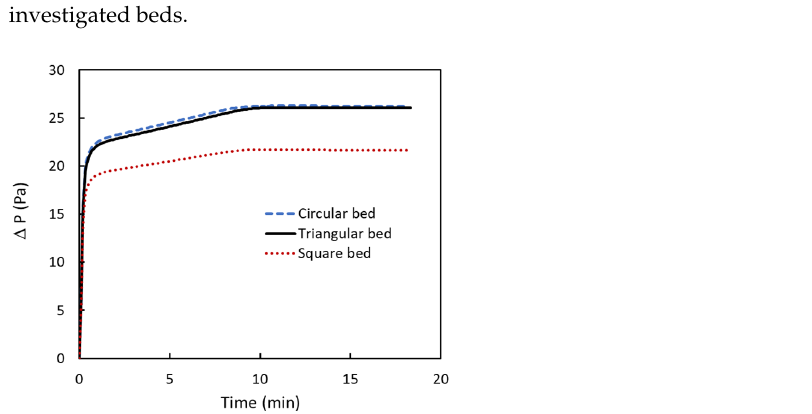
Figure 8. Pressure drop during the adsorption process for the investigated beds.